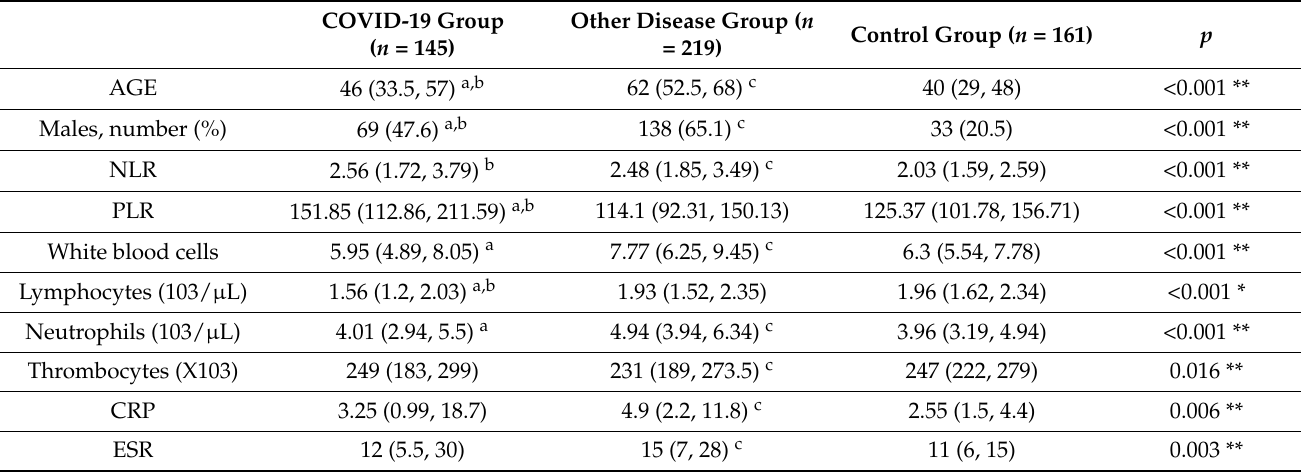
Table 1. The characteristics of the chronic disease group compared with the control group and COVID-19 group ( n = 145, data not presented, as they have already been published [3]). COVID-19 Group Other Disease Group ( n Control Group ( n = ( n = 145) = 219)